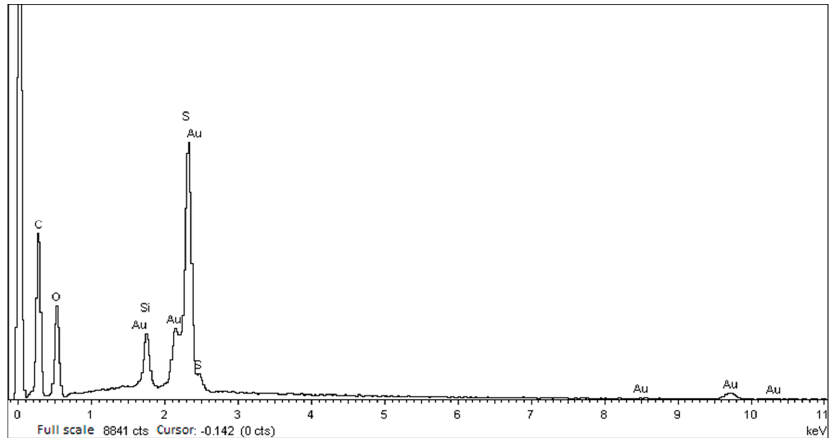
Figure 3. The elemental distribution cross section (EDX) spectrum of cross-sectional morphology for SPEKEBI-2.5-SiO 2 membrane.